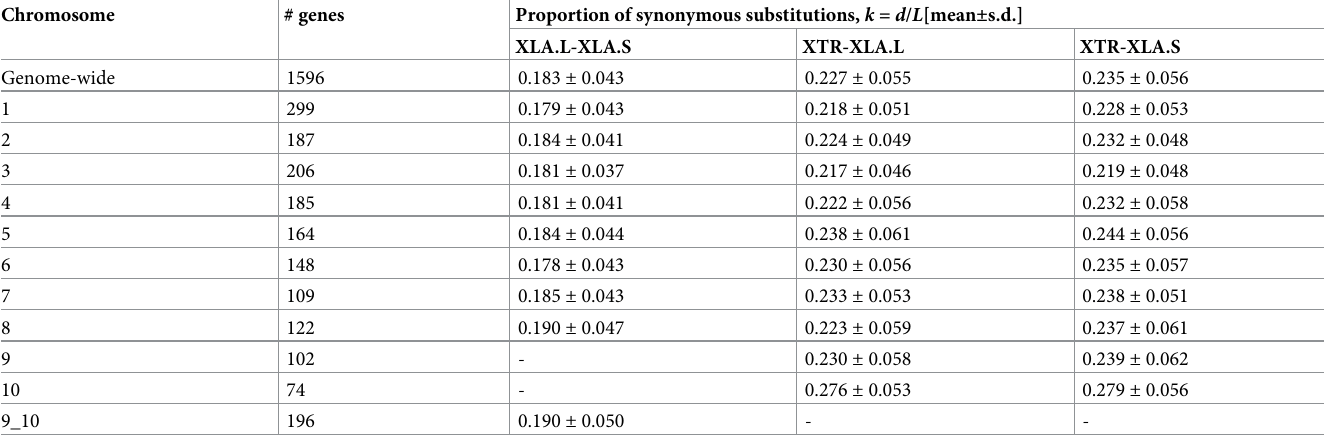
Table 2. Proportion of synonymous substitutions ( k = d/L ) calculated from pairwise comparisons of the three Xenopus genomes/sub-genomes. Chromosome # genes Proportion of synonymous substitutions, k = d / L [mean ±